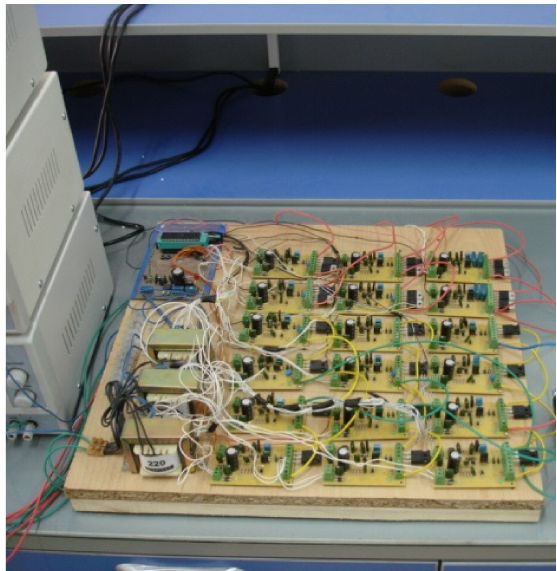
Figure 10. Photo of the experimental